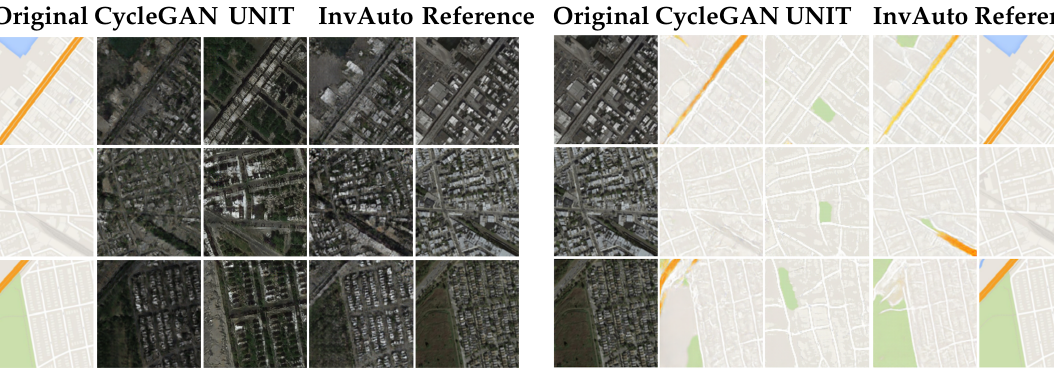
Figure 8. ( Left ) Maps-to-satellite image conversion. Zoomed image is shown in Figure A9 in Appendix A. ( Right ) Satellite-to-maps image conversion. Zoomed image is shown in Figure A10 in Appendix